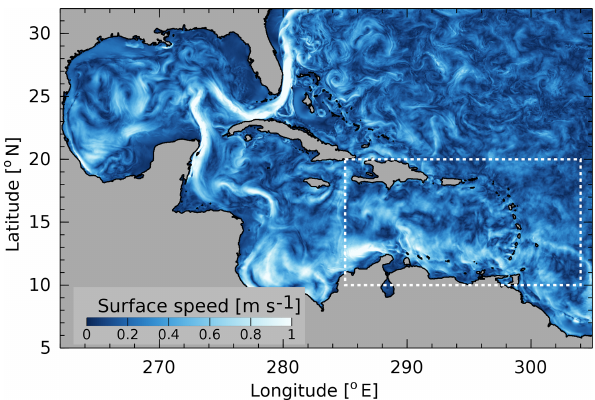
Figure 1. AMSEAS model domain. This snapshot of surface cur- rents from the representative date, 2 January 2013, shows promi- nent features of ocean circulation in the western Atlantic, namely the Loop Current in the Gulf of Mexico and the Florida Current. The rectangular box (dashed white line) indicates the region shown in subsequent plots.